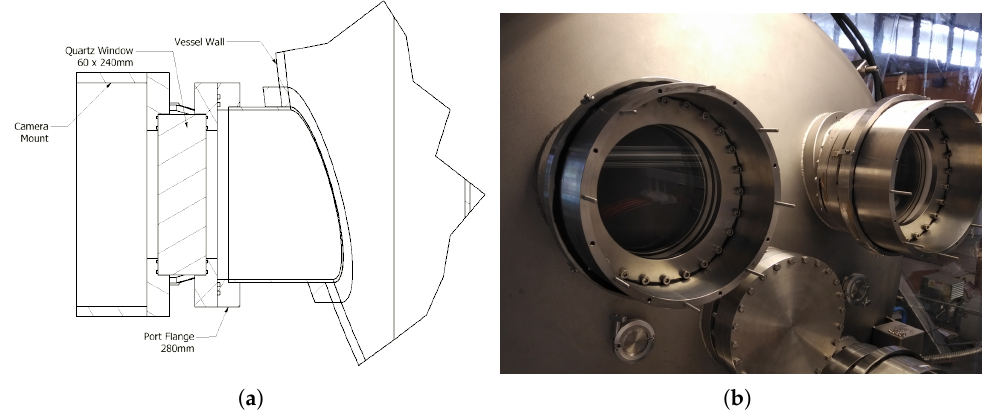
Figure 4. ( a ) Drawing of the optical flange with the camera mount. The thick quartz is necessary for ensuring that the assembly can withstand the pressure difference between the vessel pressure and ambient pressure. ( b ) A photograph of the assembly with the camera removed.